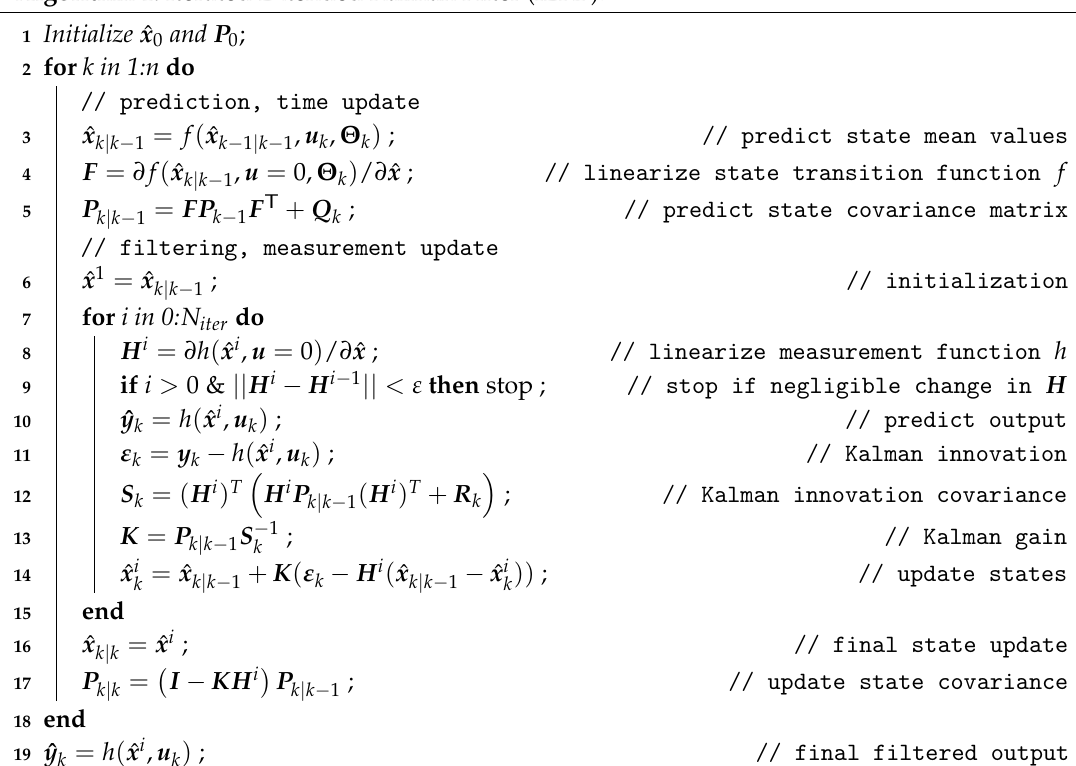
Algorithm 1: Iterated Extended Kalman Filter